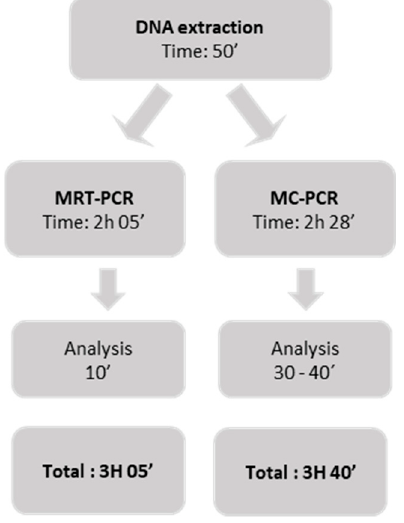
Figure 2. Response time for both methods.